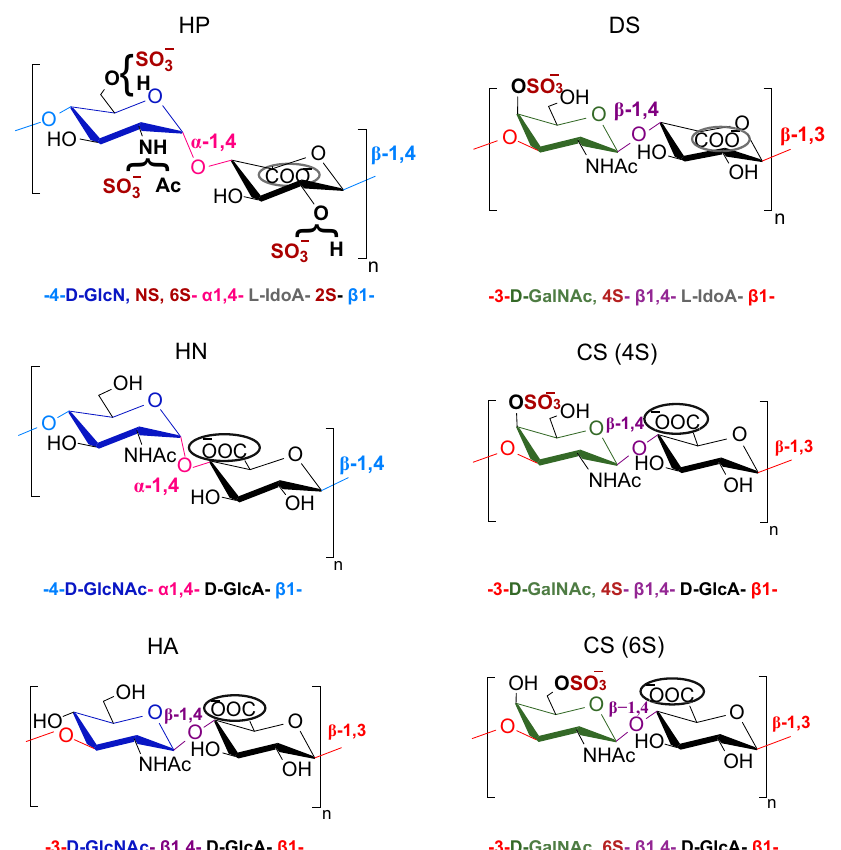
Fig. 1 | Constituent disaccharide units of the different GAGs studied: heparin (HP), heparosan (HN), hyaluronic acid (HA), dermatan sulfate (DS), and chon- droitin sulfate (CS). The structural determinants studied are represented by different colors for the different types of monosaccharide units ( D -Glc (dark blue), D -Gal (green), or uronic acid (black)), the type of glycosidic linkage within